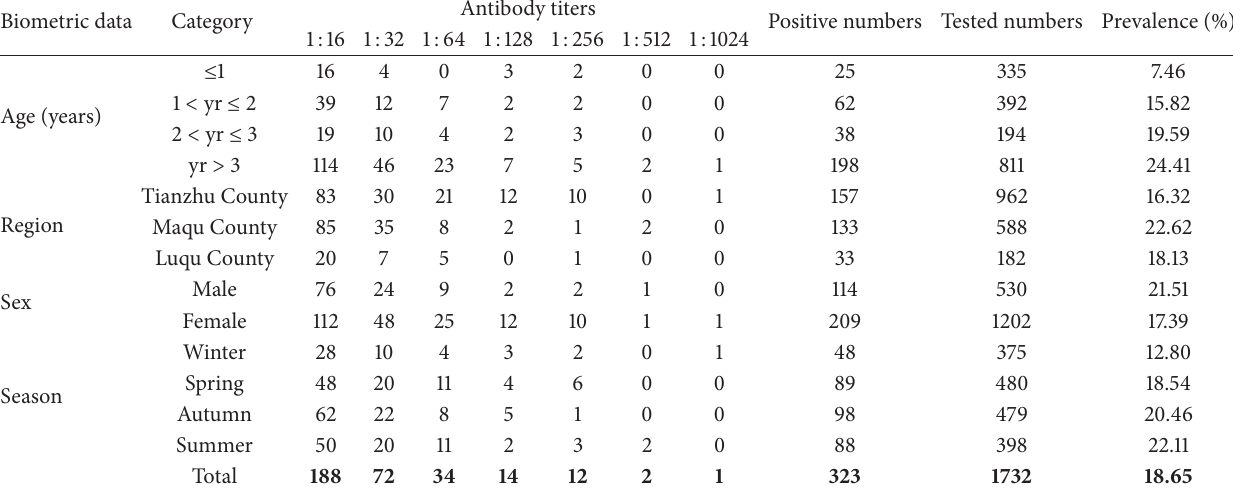
Table 3: Seroprevalence of Chlamydia abortus infection in Tibetan sheep in Gansu, China, determined by indirect haemagglutination (IHA)